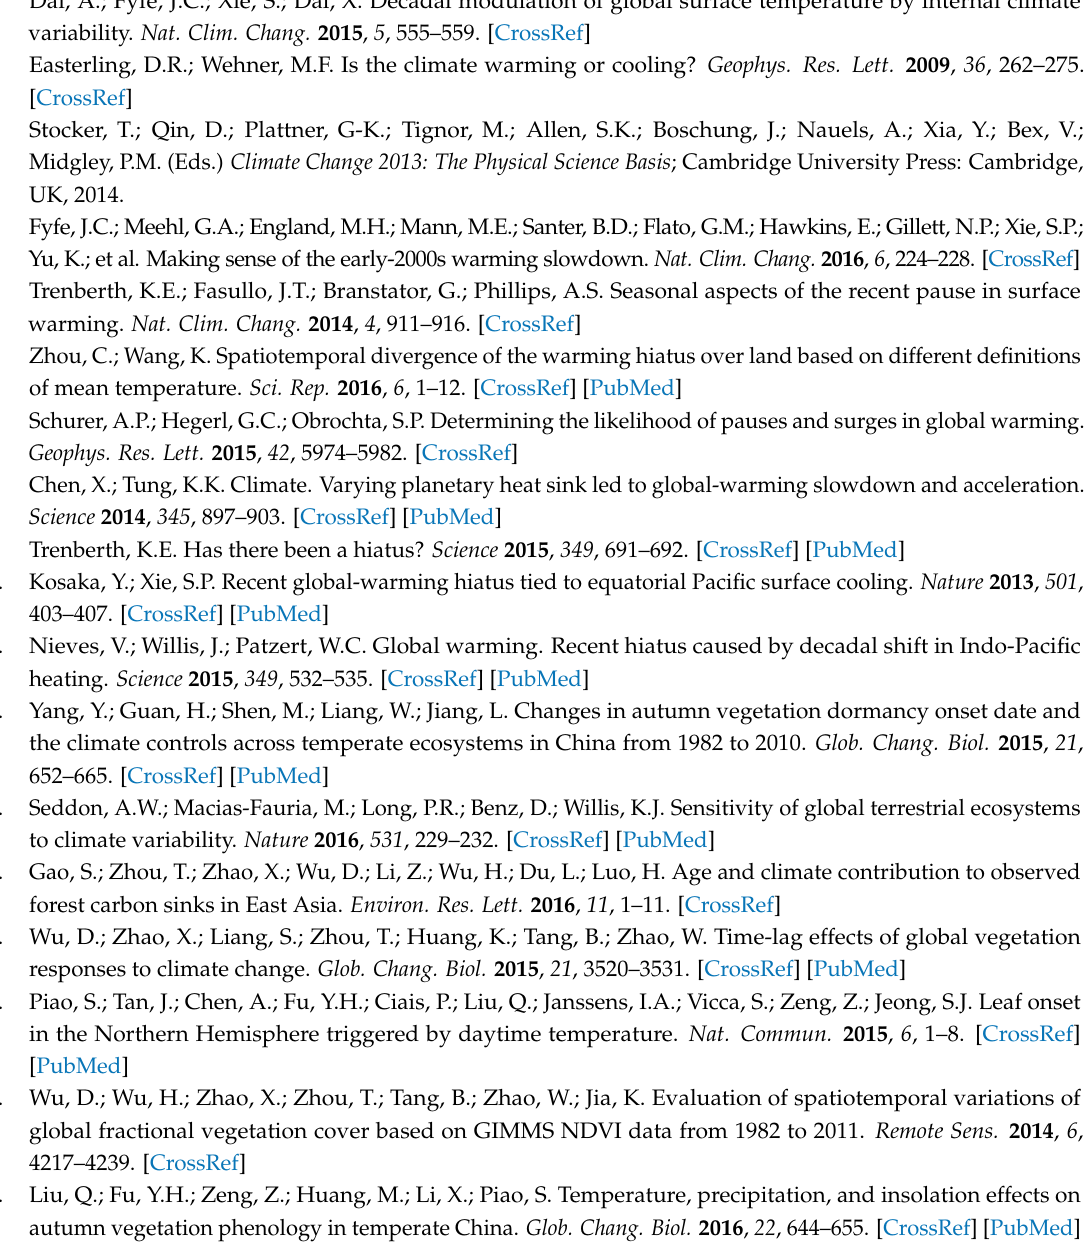
Figure S1: Comparison of model-simulated LAI trends in regions with warming hiatuses, Figure S2: Comparison of model-simulated LAI trends in regions without warming hiatuses, Figure S3: Trends of Global Land Surface Satellite (GLASS) LAI in six